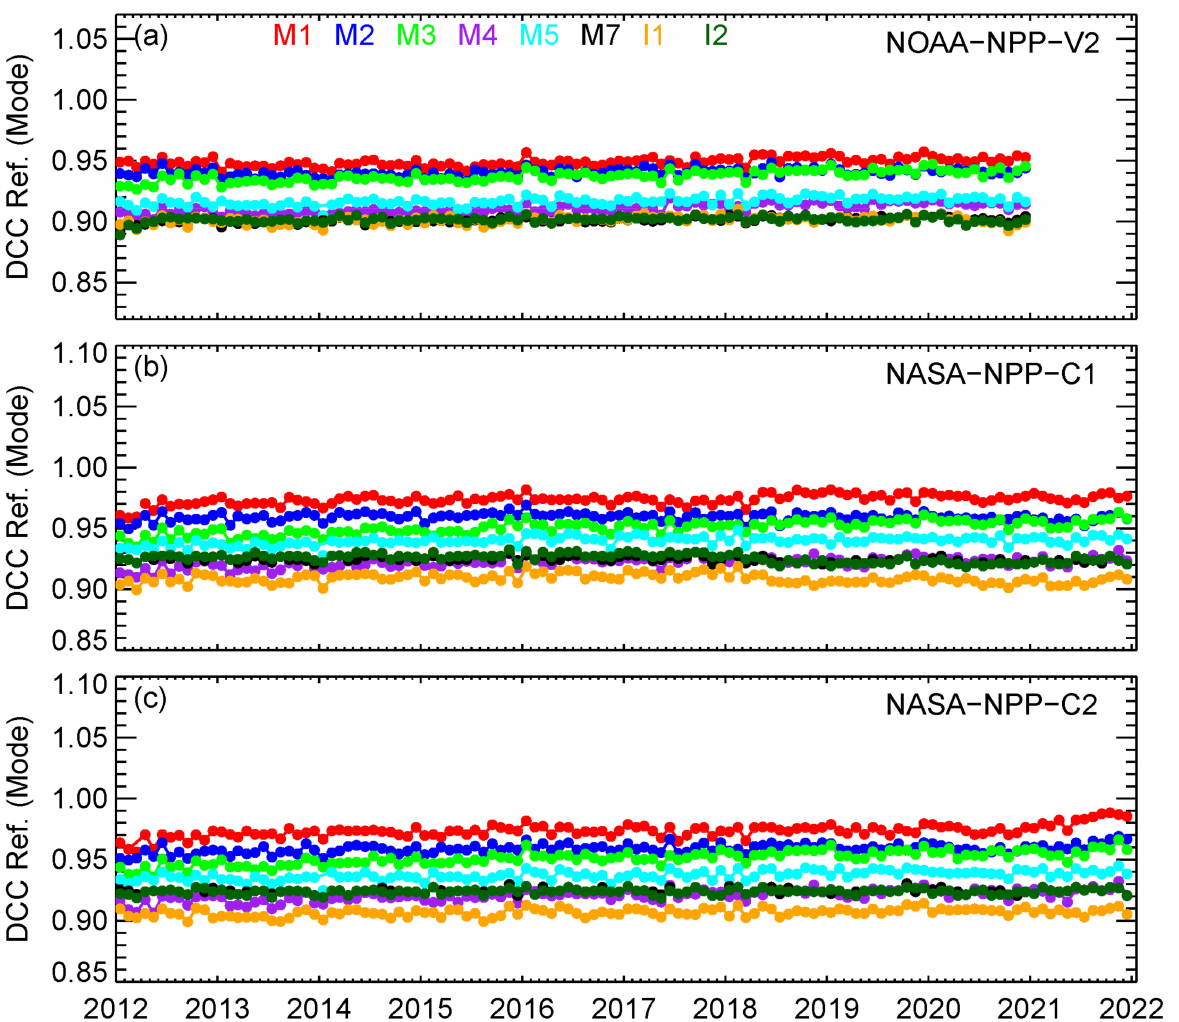
Figure 1. Monthly DCC time series of S-NPP VIIRS VIS/NIR bands: ( a ) NOAA-NPP-V2 (2012–2020), ( b ) NASA-NPP-C2 (2012–2021), and ( c ) NASA-NPP-C2